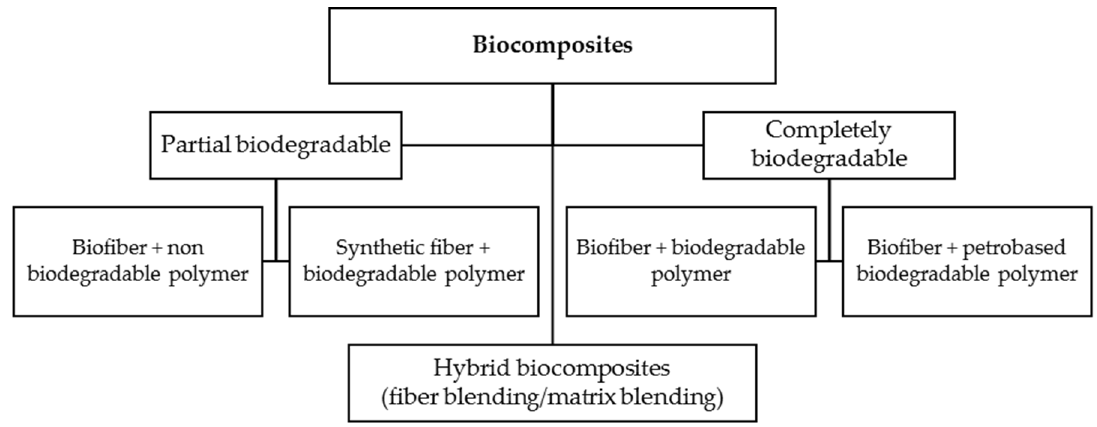
Figure 2 . Classification of biocomposites. Adapted from [5] . Figure 2. Classification of biocomposites. Adapted from